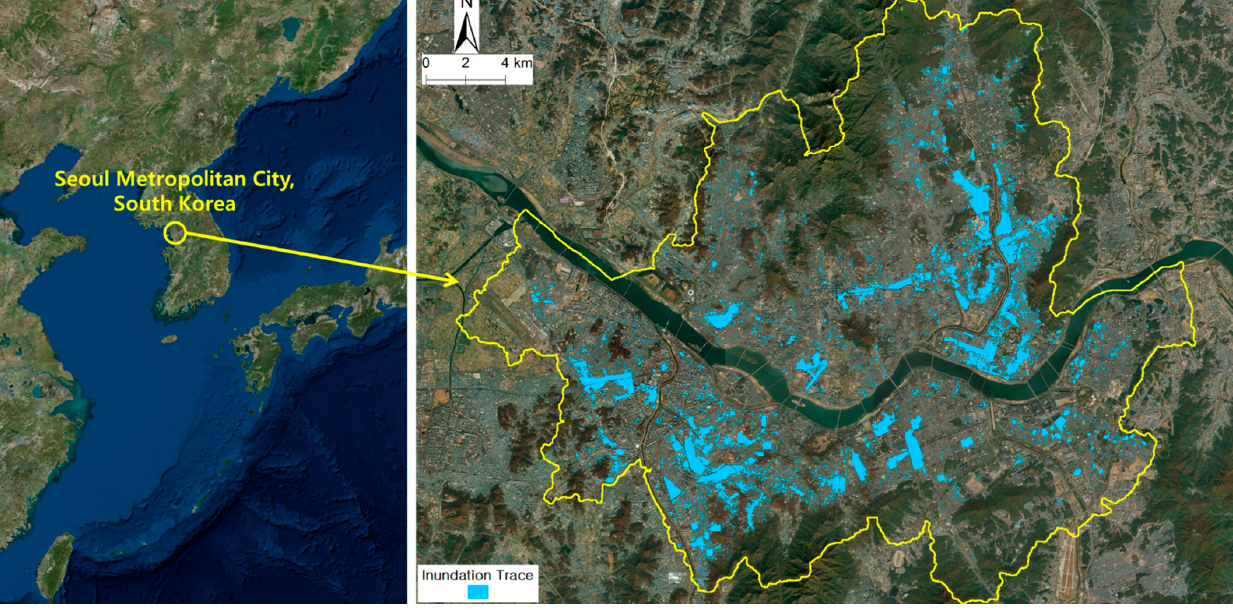
Figure 2. Inundation traces that occurred in 2001 in Seoul, the study